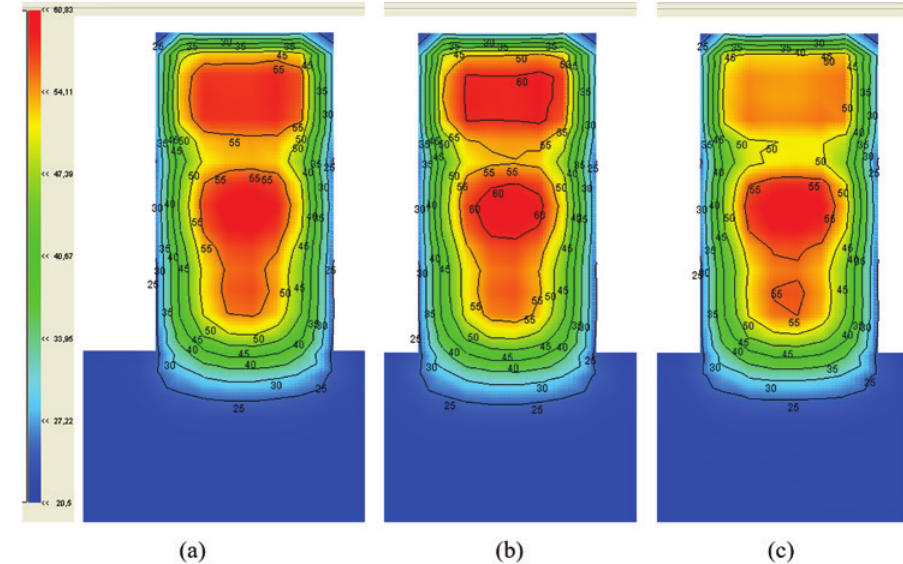
Isotherm plots showing the temperature gradients from surface to core of (a) reference concrete (CC) after 144h, (b) concrete with tire granules (CG) after 128h, and (c) concrete with tire fibers (CF) after